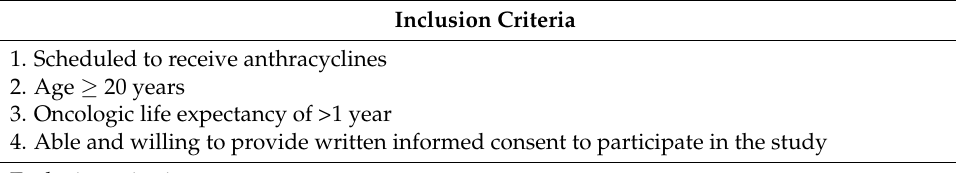
Table 1. Inclusion and exclusion